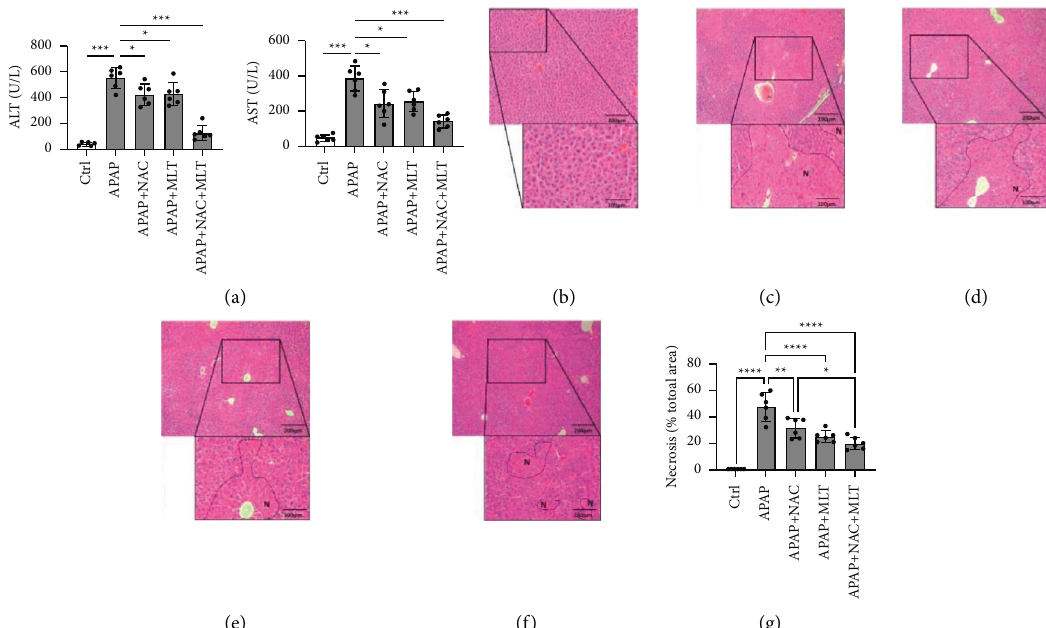
Figure 1: MLT displays a strengthened role in hepatic protective NAC therapy. (a) Serum level of ALT and AST for each group. H&E staining for wild-type mice (b), single APAP treated mice (c), APAP with NAC treated mice (d), APAP with MLT treated mice (e), and APAP with two drugs (f) and statistical quantification of necrosis in liver tissue for each group (g). The columns are shown as means ± SD ( n � 6). N represents necrosis area. ( ∗ p < 0 . 05, ∗∗ p < 0 . 01, ∗∗∗ p < 0 . 001).